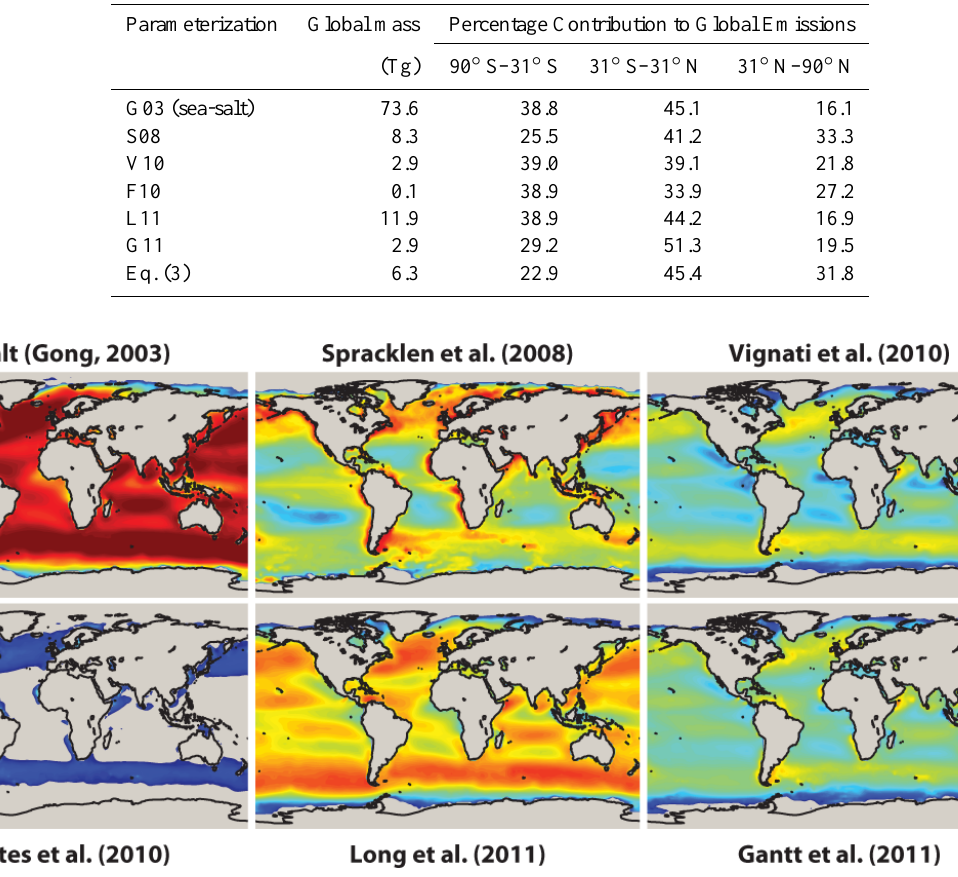
Table 2. GEOS-Chem annual average global sea-salt and marine POA emissions and zonal percentage contributions.